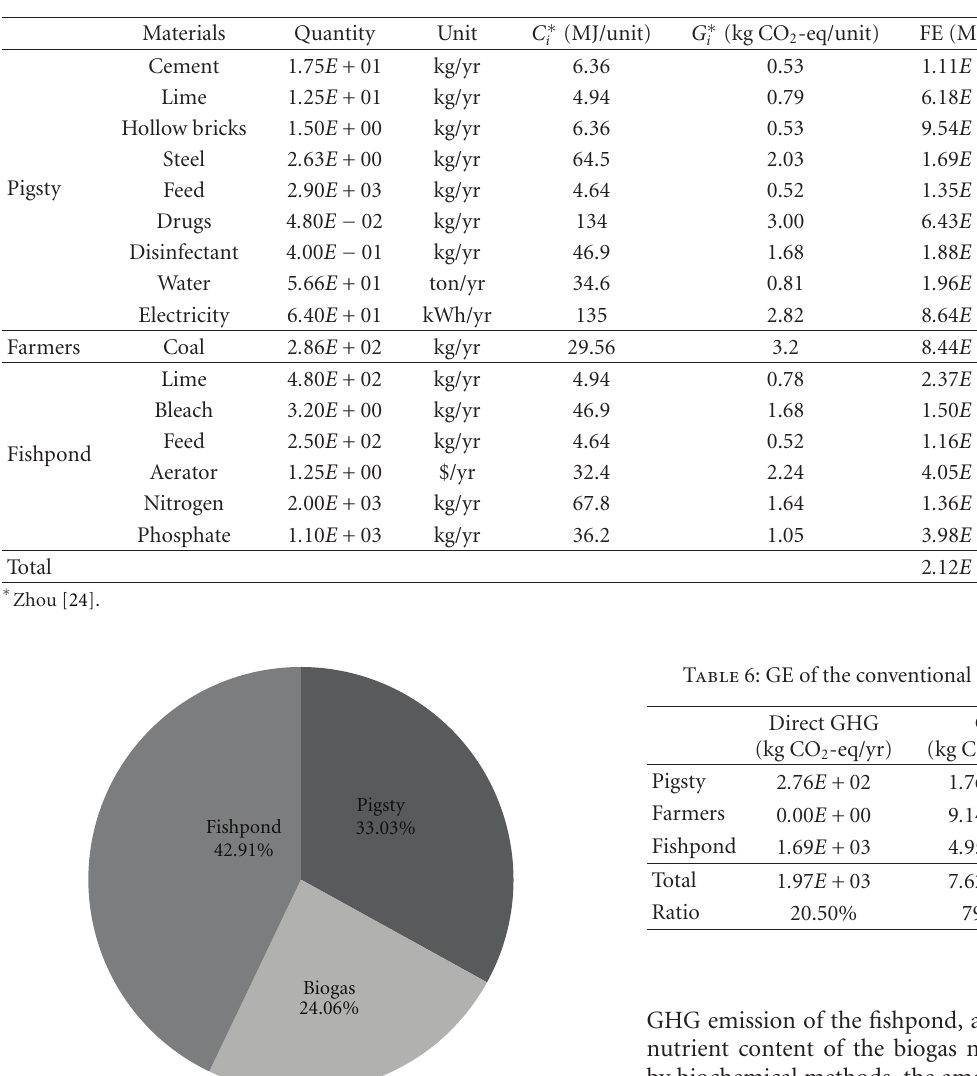
Table 5: FE cost and GE in emissions of the conventional animal husbandry system.